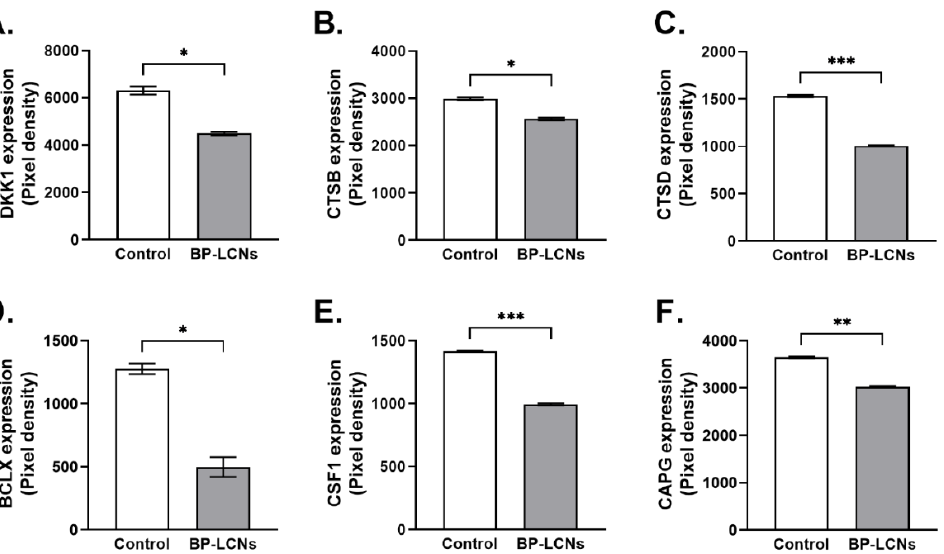
Figure 13. Effects of BP-LCNs on expression levels of proteins related to migration in A549 cells. A549 cells were incubated at 37 ◦ C for 24 h in the absence or presence of BP-LCNs (final concentration 5 µ M). The figure shows protein expression levels of DKK1 ( A ), CTSB ( B ), CTSD ( C ), BCLX ( D ), CSF1 ( E ), and CAPG ( F ). The protein expression levels were determined using an oncogene protein array kit and by quantifying pixel densities of the respective proteins. The values represent means ± SEM of 3 independent experiments. Note: * p < 0.05, ** p < 0.01, *** p < 0.001. Abbreviations: BP-LCNs, berberine–phytantriol liquid crystalline nanoparticles; DKK1, Dickkopf Wnt signaling pathway inhibitor 1; CTSB, cathepsin B; CTSD, cathepsin D; BCLX, bcl-2 like protein,